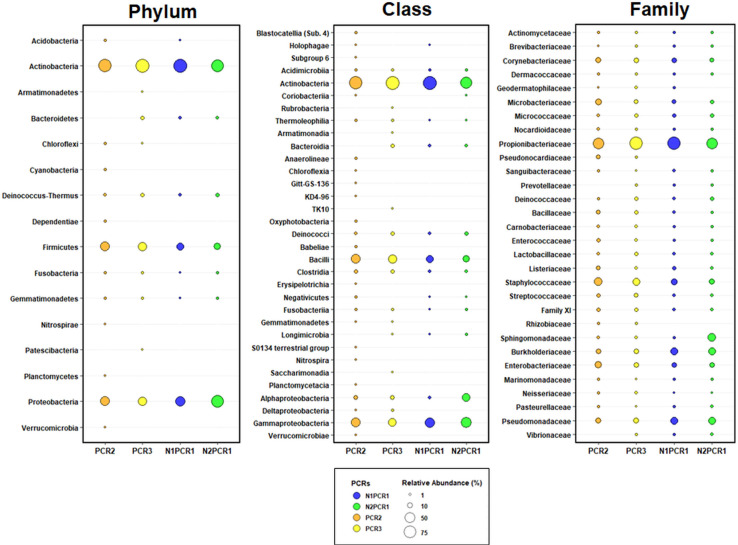
Taxonomic bubble plot of bacterial relative abundance at phylum, class, and family level present in different PCR primer pair combinations. Circle sizes represent the relative abundance, and colors indicate PCR primer pairs used. All phyla and classes were shown, while only the most abundant bacteria (98% of reads) at family level were represented. Horizontal lines indicate the taxonomy lineage from each bacterial family.